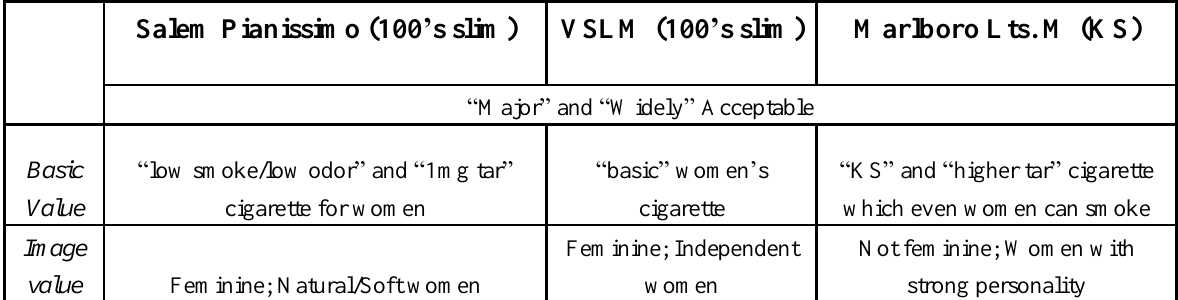
Table 2. PMI analysis of the image profile of major menthol brand styles in Japan, 1998 (adapted from [49]).